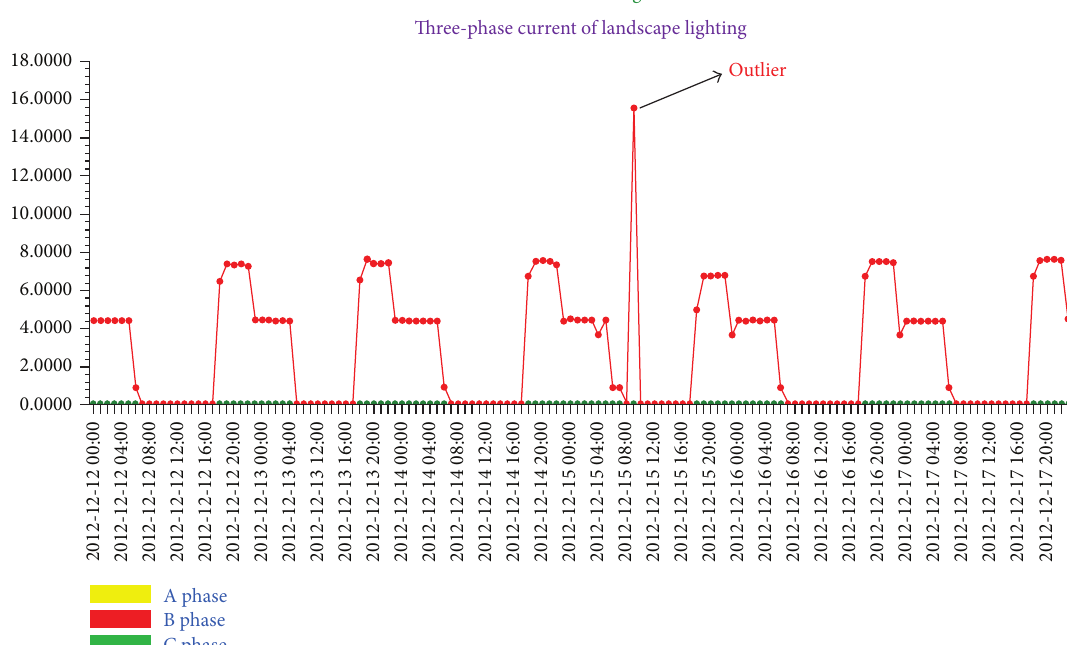
Figure 1: Outlier in building energy consumption monitoring system.